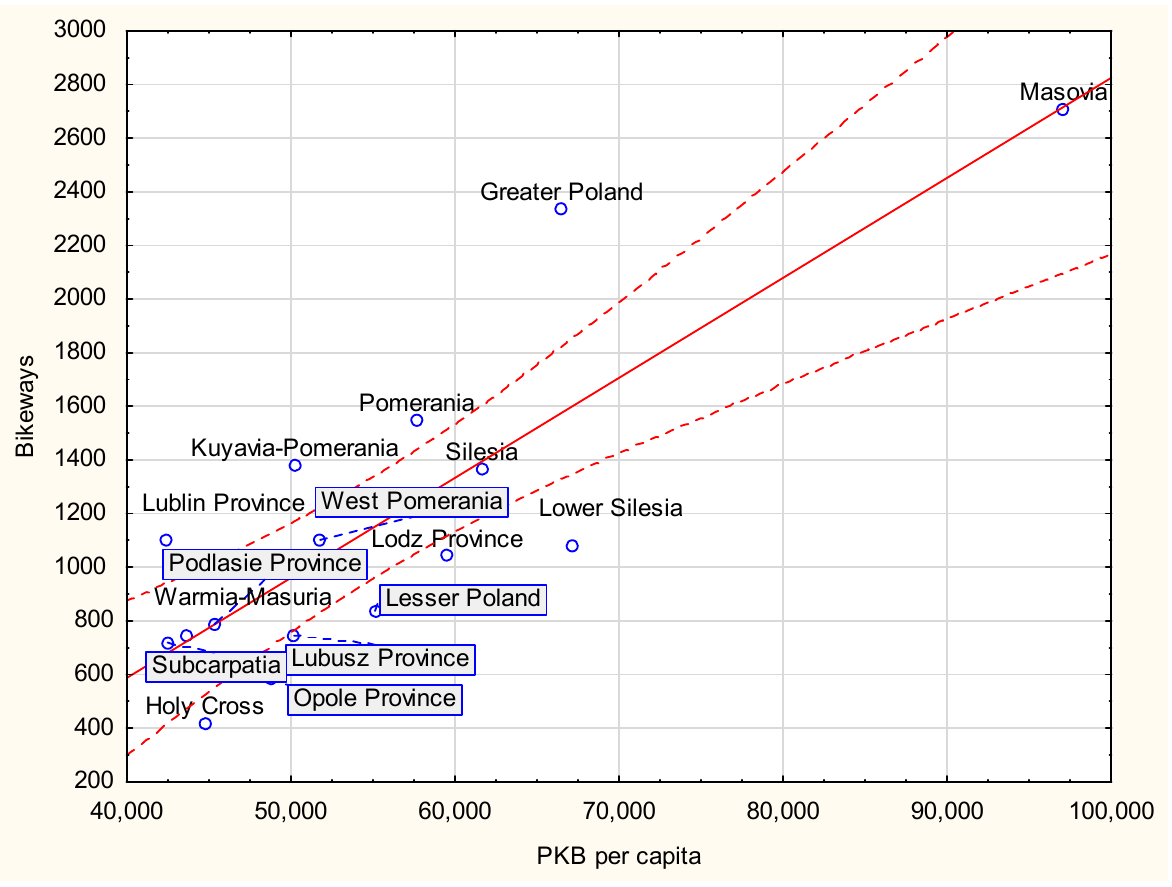
Figure 5. Relationship between the length of bicycle paths in a province and GDP per capita. Source: Author own analysis.